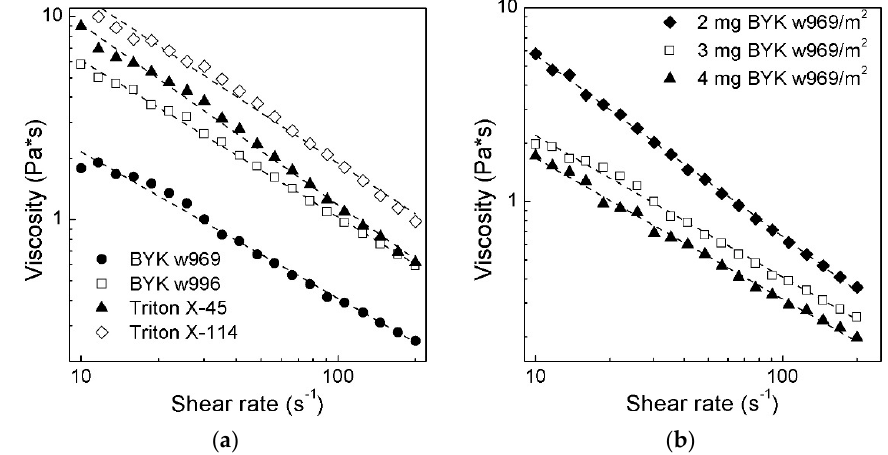
Figure 2. Viscosity of HDDA suspensions as a function of shear rate with 20 vol.% of 8YSZ: ( a ) influence of different type of surfactants; ( b ) influence of BYK w969 concentration at 20 °C.